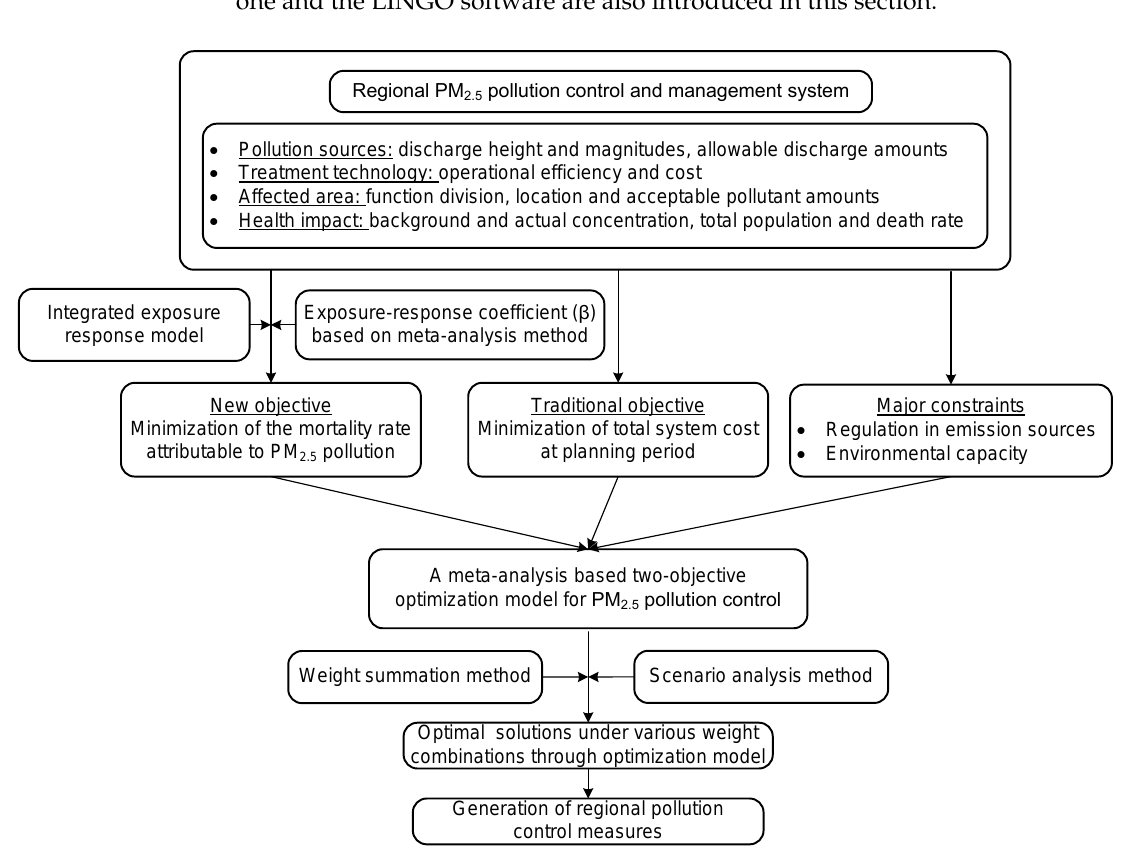
Figure 1. The formulation and solution framework of the proposed optimization model.